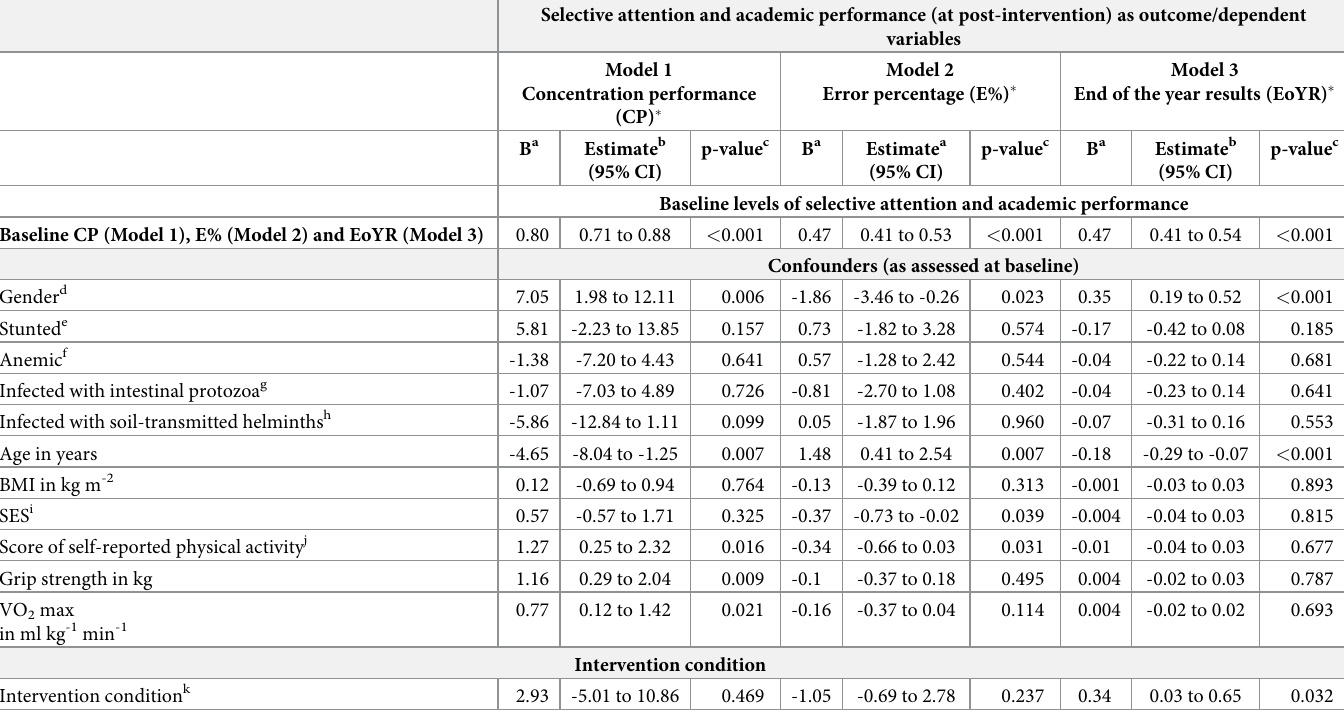
Table 3. Effect of intervention condition on the three outcome variables at post-intervention (May 2016), after adjustment for clustering effects of school classes, controlling for baseline levels (February 2015) of selective attention and academic performance, and potential confounders, Port Elizabeth, South Africa. Selective attention and academic performance (at post-intervention) as outcome/dependent